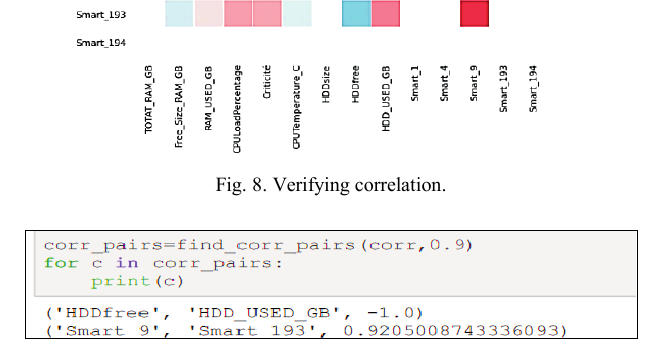
Fig. 9. Finding high correlation pairs.